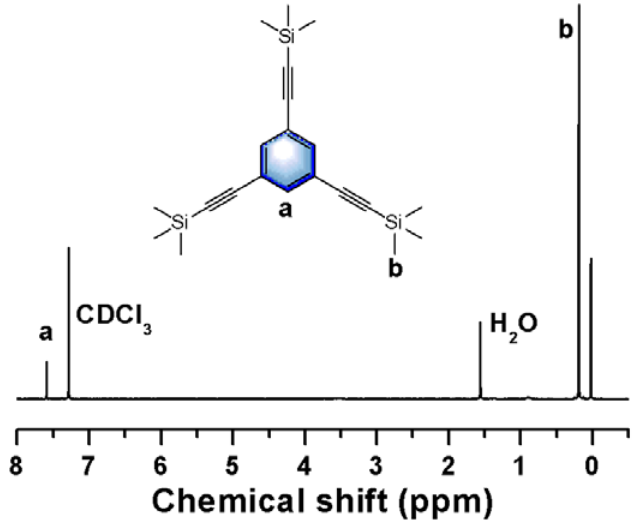
Figure 1. 1 H NMR spectrum of intermediate a . Figure 2 showed the 1 H NMR spectrum of intermediate b . The signal at δ = 7.66